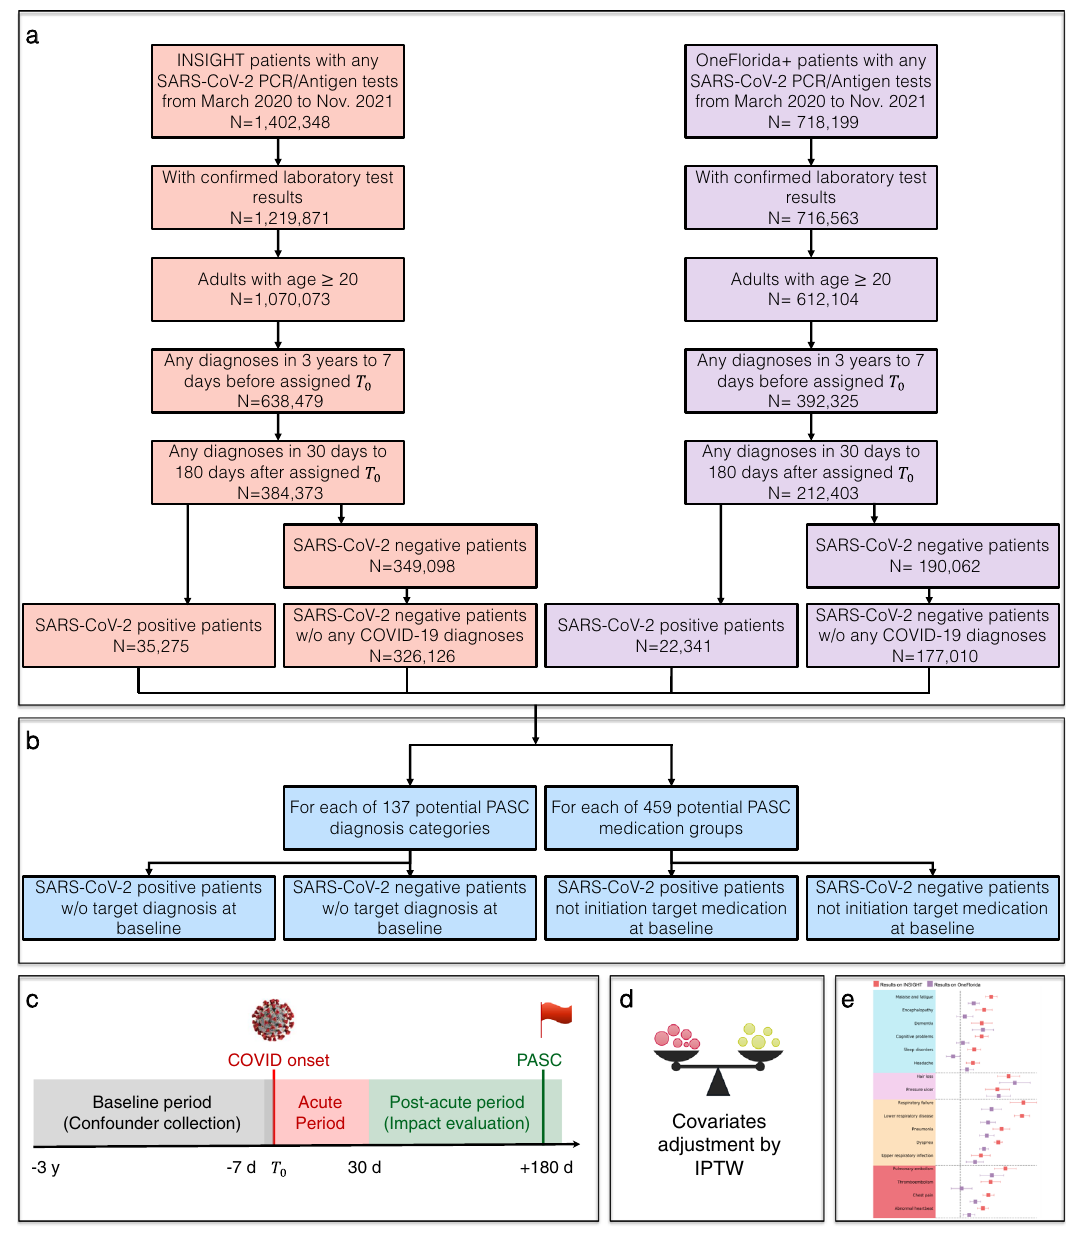
Fig. 1 | Overall data-driven high-throughput screening framework. a Selection of patients from the INSIGHT and OneFlorida+ EHR warehouses, March 2020 to November 2021. b High-throughput construction of PASC-speci fi c case and con- trol groups thatpatients didnothave target condition at baseline. c Study design. The PASC outcomes were ascertained from day 30 after the SARS-CoV-2 infection and the adjusted risk was computed 180 days after the SARS-CoV-2